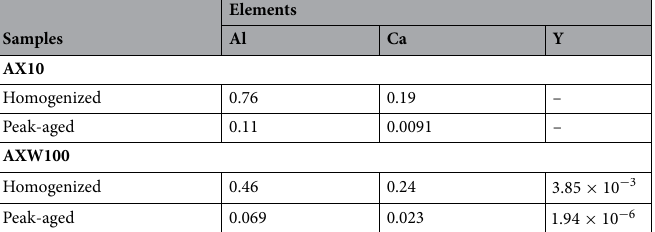
Table 5. Calculated composition (in at.%) of the matrix for the AX10 and AXW100 alloys at equilibrium. The amount of Al, Ca and Y solutes dissolved in the matrix at the homogenization (500 °C) and aging (250 °C)